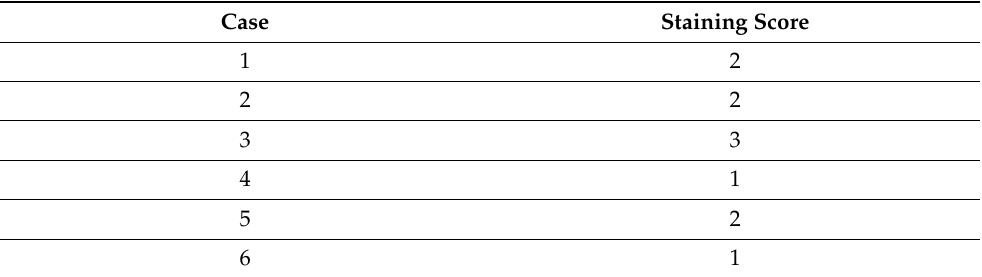
Table 1. Summary of c-KIT